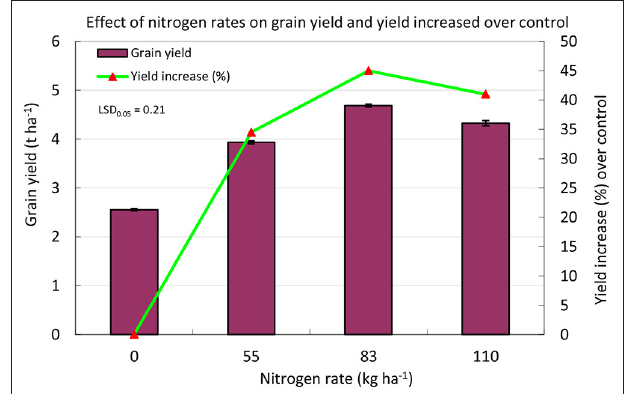
FIGURE 3 | Mean rice grain yield and its increase as influenced by N rates and genotypes in a drought-prone rainfed rice system. Bars indicate the standard error of the